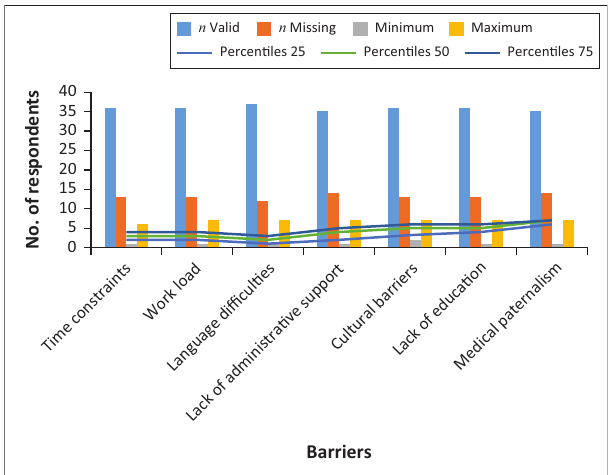
FIGURE 5: Barriers to obtaining informed consent as reported by respondents.